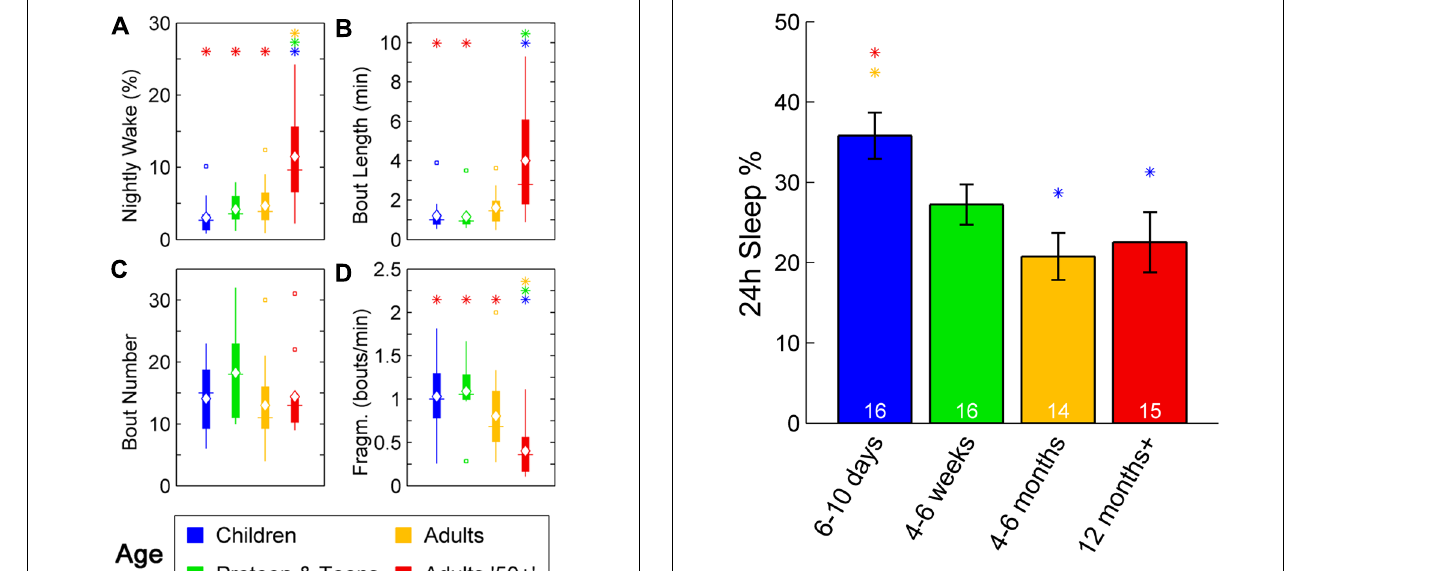
FIGURE 3 | Sleep percentage across 24 h in zebrafish. The youngest group (6–10 days post-fertilization) sleep significantly more over a full 24-h time period than adult fish (4–6 and 12 + months). Colored asterisks above bars indicate a statistically significant difference between the bar group and the group with the corresponding color of the asterisk.White numbers on the bars indicate the number of zebrafish in each age